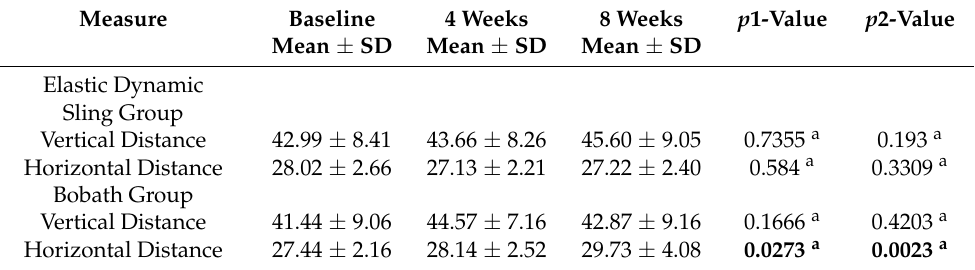
Table 4. Comparison of vertical and horizontal distances within the groups at four and eight weeks.